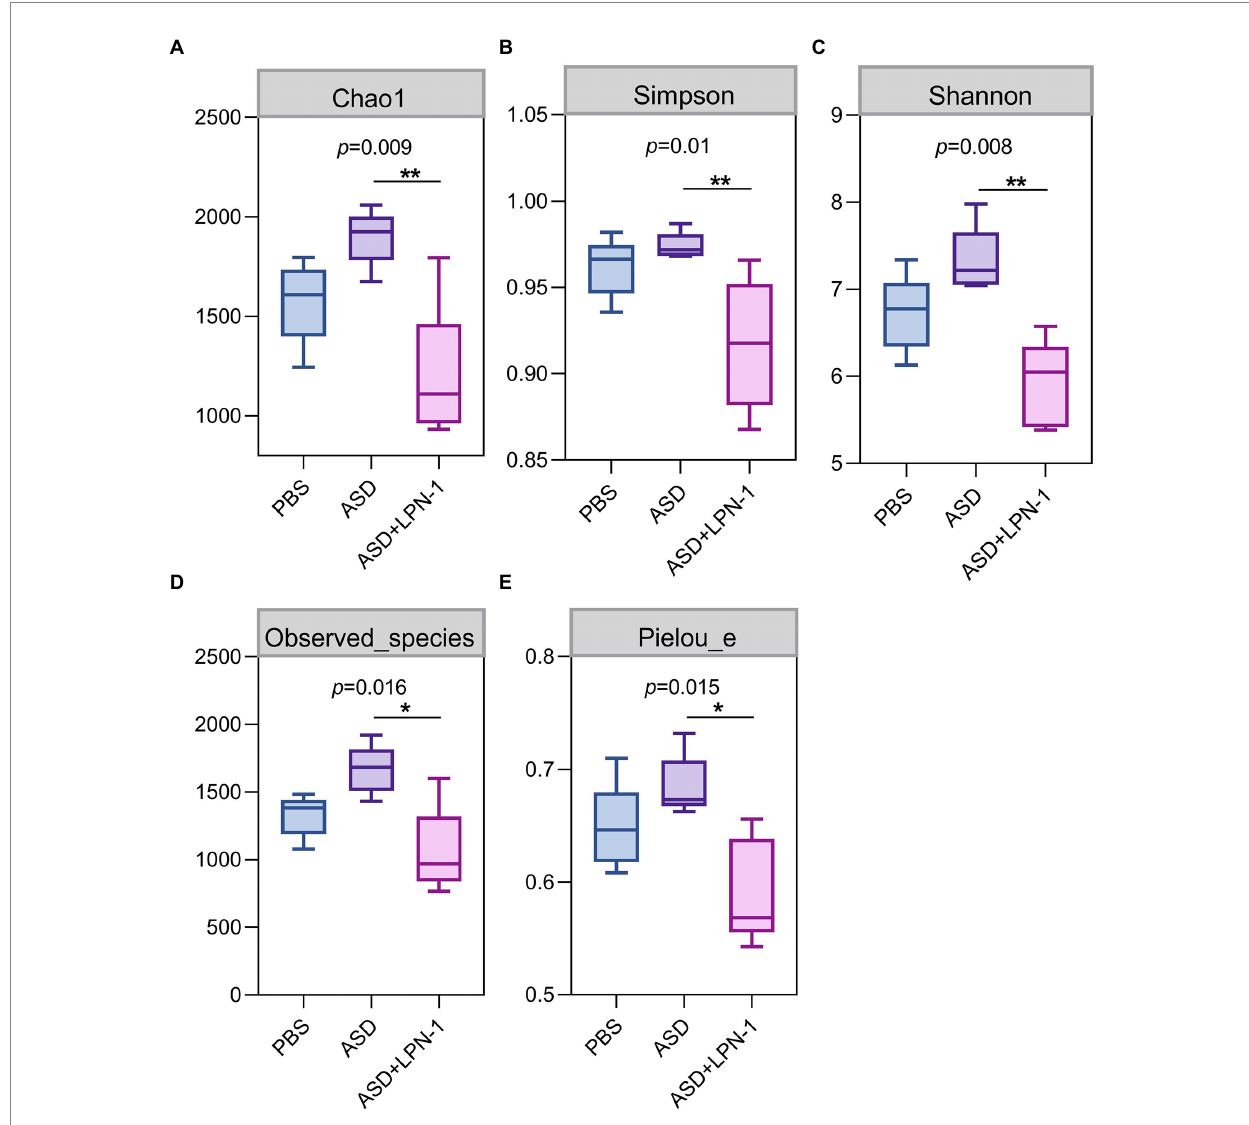
FIGURE 5 The alpha diversity assessed by Chao1 (A) Simpson (B) Shannon (C) Observed_species (D) Pielou_e index (E) . Statistically significant differences among groups were determined per the Kruskal-Wallis test. n =5 per group. * p < 0.05. ** p <